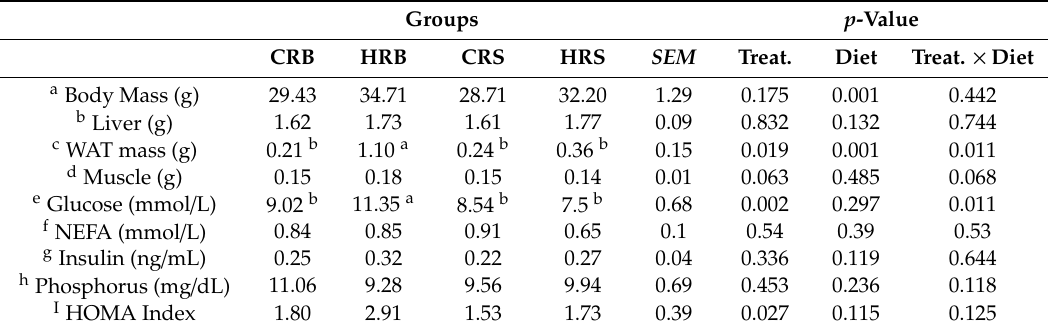
Table 3. Physical and blood biomarkers of mice receiving di ff erent treatments (butaphosphan or saline), control or hypercaloric diet, and food restricted (Experiment 2). Groups p -Value CRB HRB CRS HRS SEM Treat. Diet Treat. × Diet a Body Mass (g)